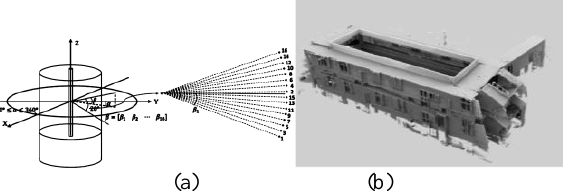
Figure 2. Illustration of indoor LiDAR-based indoor point cloud. (a) multi-beam laser scanning sensor model. (b) the high- accuracy reference TLS point cloud.